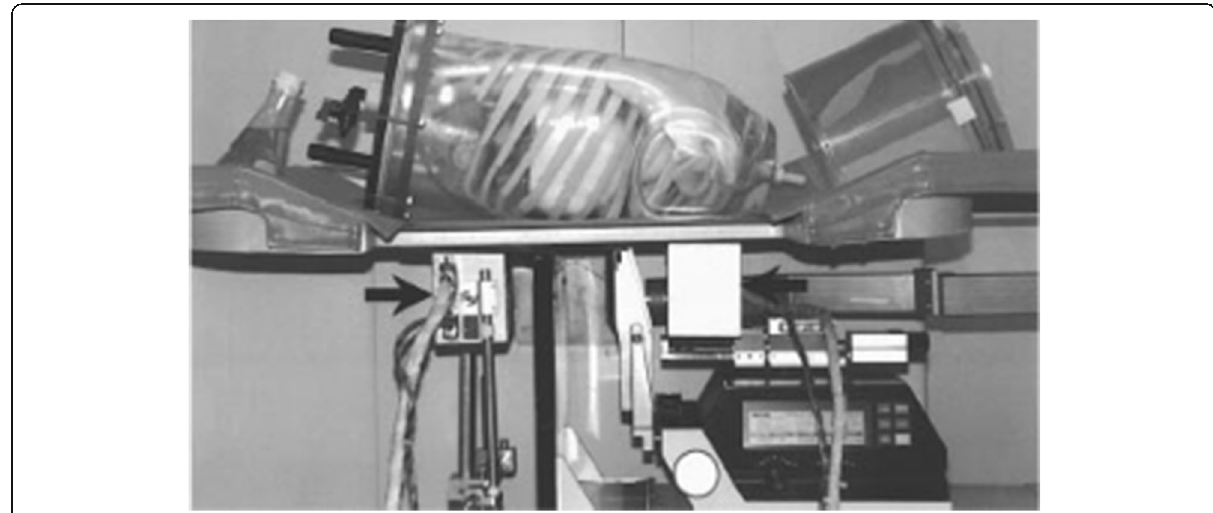
Fig. 19 PEM detectors installed on an autopsy system